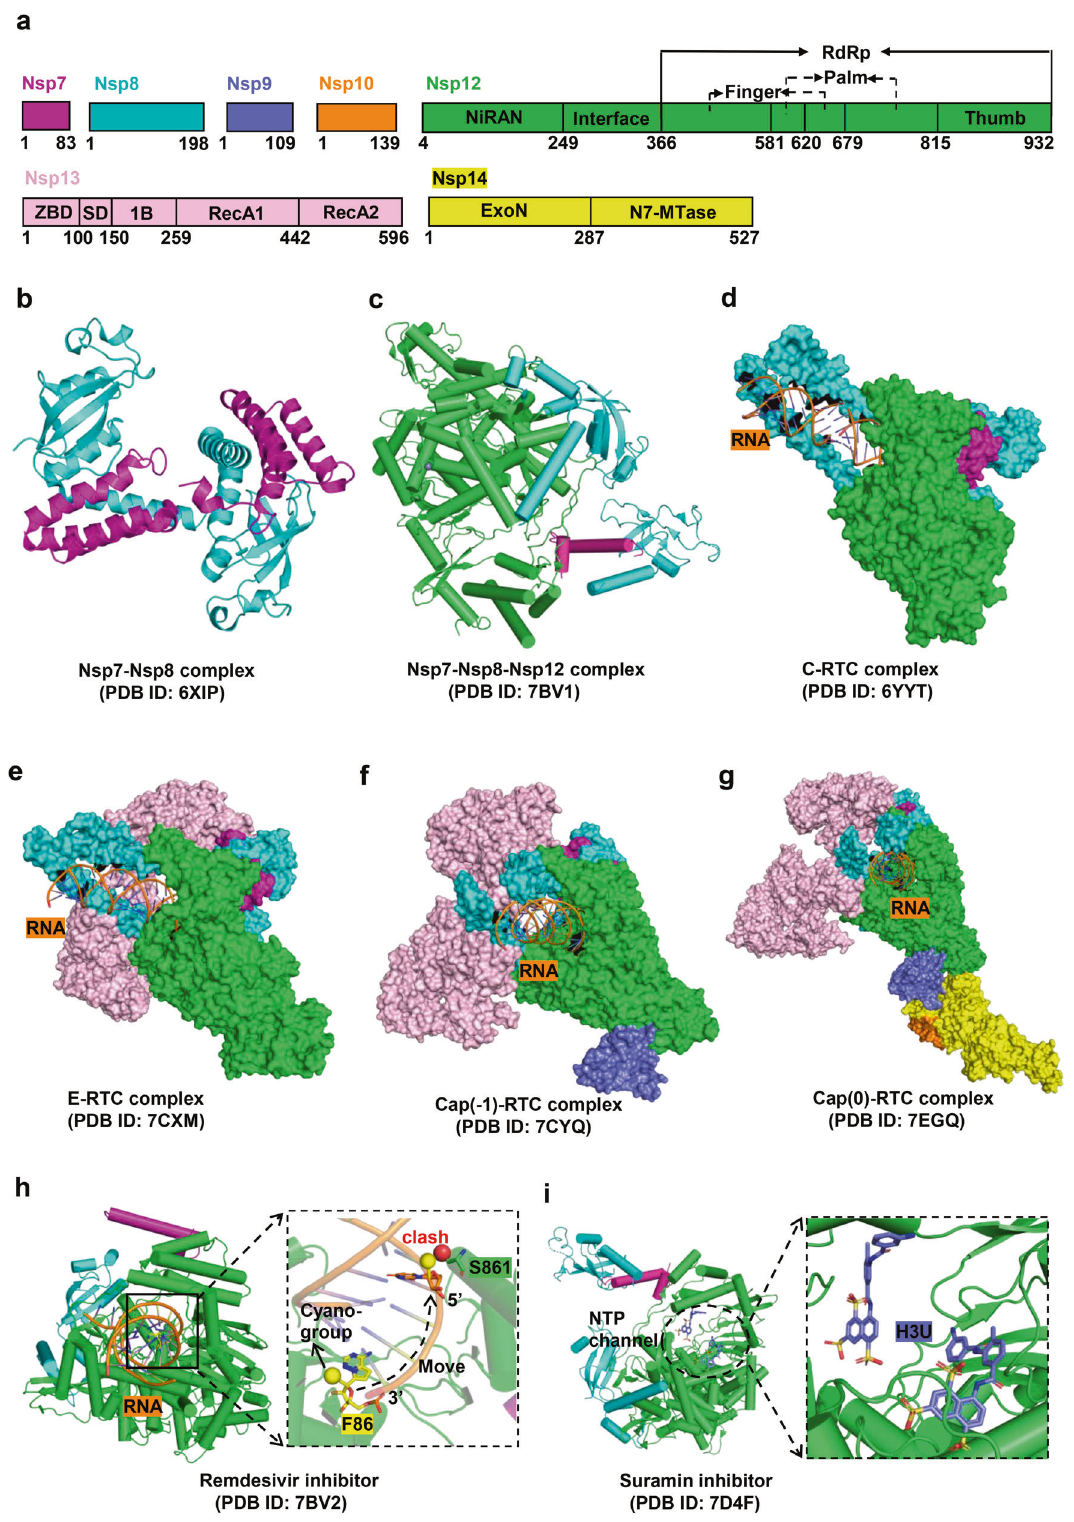
Fig. 6 Structures of SARS-CoV-2 RTC complexes and cognate inhibitors. a Schematic representations of Nsp7, Nsp8, Nsp9, Nsp10, Nsp12, Nsp13, and Nsp14 proteins organizations. b – g Structures of Nsp7-Nsp8, Nsp7-Nsp8-Nsp12, the central RTC (C-RTC, Nsp12-Nsp7- Nsp8), the elongation RTC (E-RTC, Nsp12-Nsp7-Nsp8-Nsp13), cap ( − 1)-RTC (Nsp12-Nsp7-Nsp8-Nsp13-Nsp9), and cap (0)-RTC (Nsp12-Nsp7-Nsp8- Nsp13- Nsp9-Nsp14-Nsp10) complexes, respectively. h, i Structures of C-RTC with bound inhibitors Remdesivir (F86) can bind to the RNA strand. The schematic of the inhibition state is shown on the right ( h ). Two suramin (H3U) molecules occupy the catalytic cavity ( i )